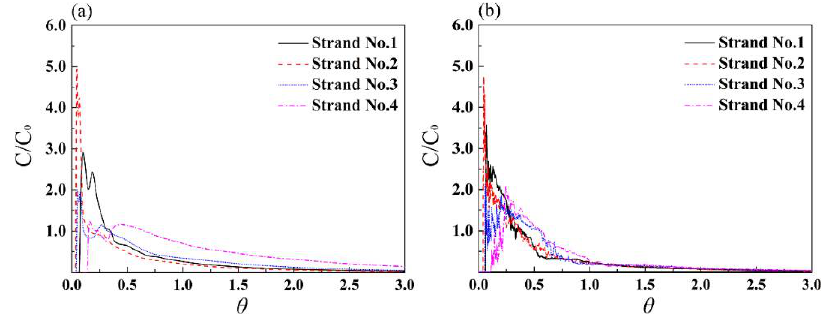
Figure 14. Comparison of RTD curves of case A0 between simulation ( a ) and experiment ( b ).